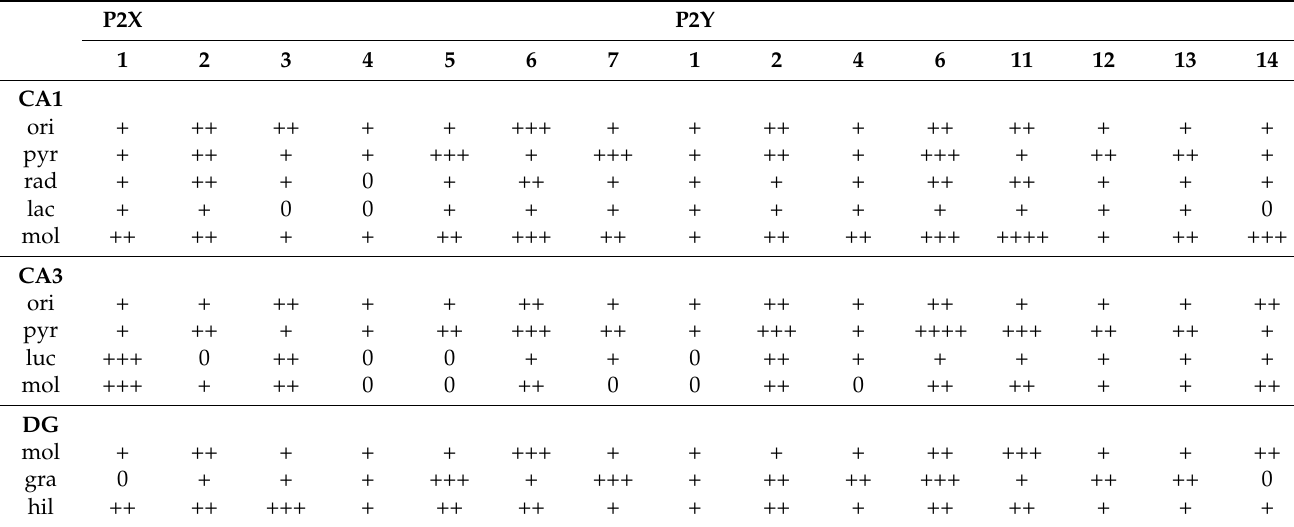
Table 1. Spatial distribution of P2 receptor